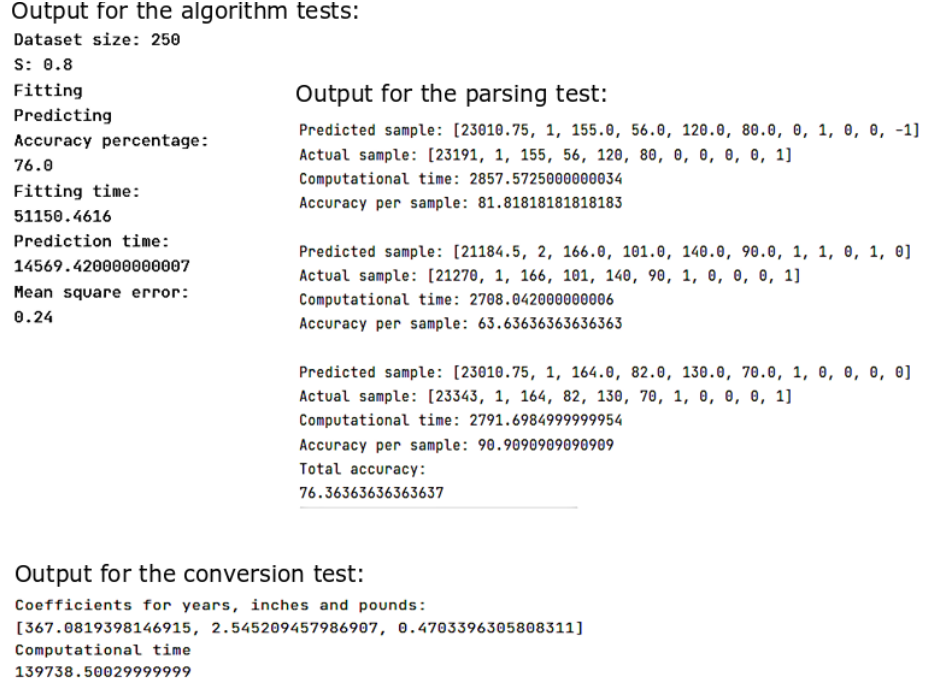
Figure 6. Output of implemented prototype to display results of NLP in medical data